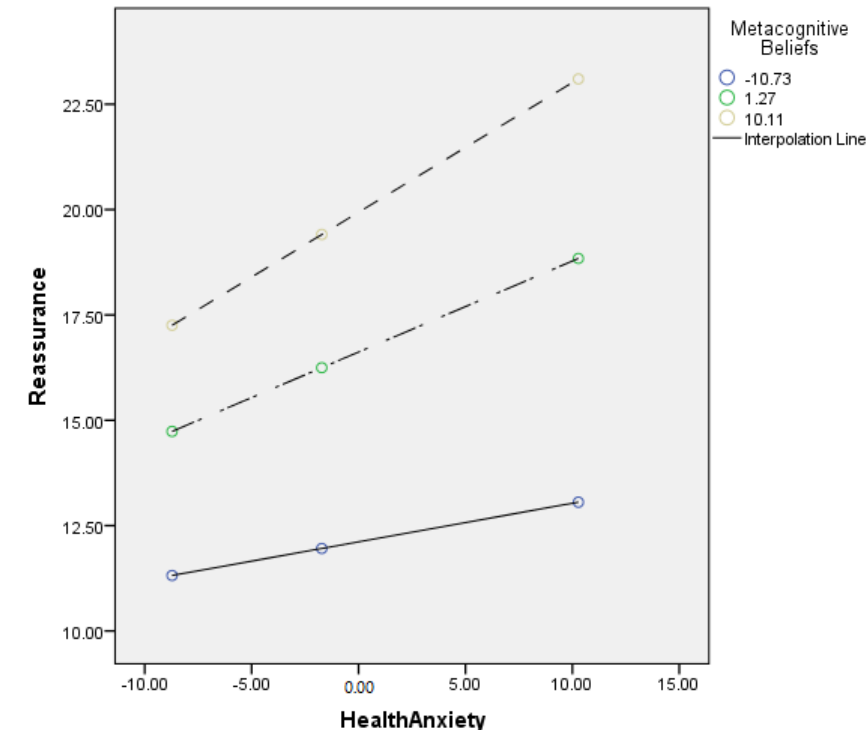
and Figure 5. Graphical presentation of moderating role of metacognitive beliefs between health anxiety and reassurance.